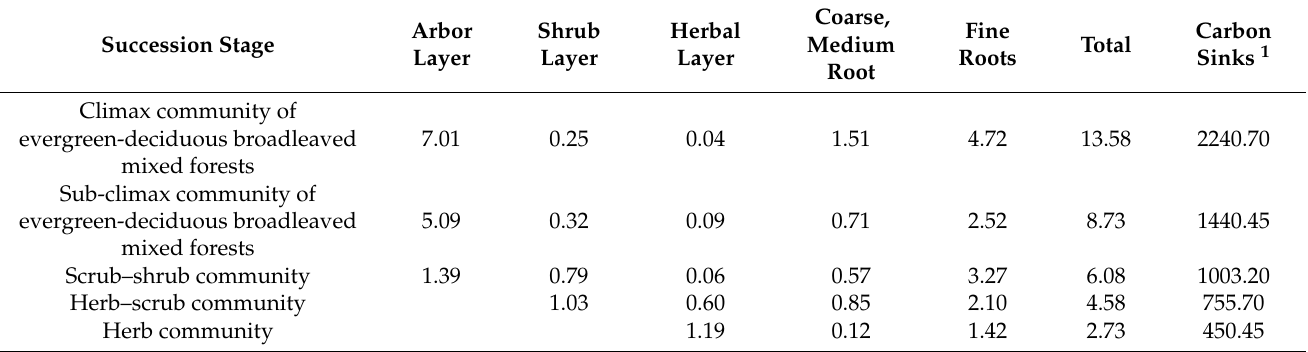
Table 3. Distribution of net primary productivity (t hm − 2 y − 1 ) and carbon sink capacity (tCO 2 km − 2 y − 1 ) at various stages of karst vegetation succession in